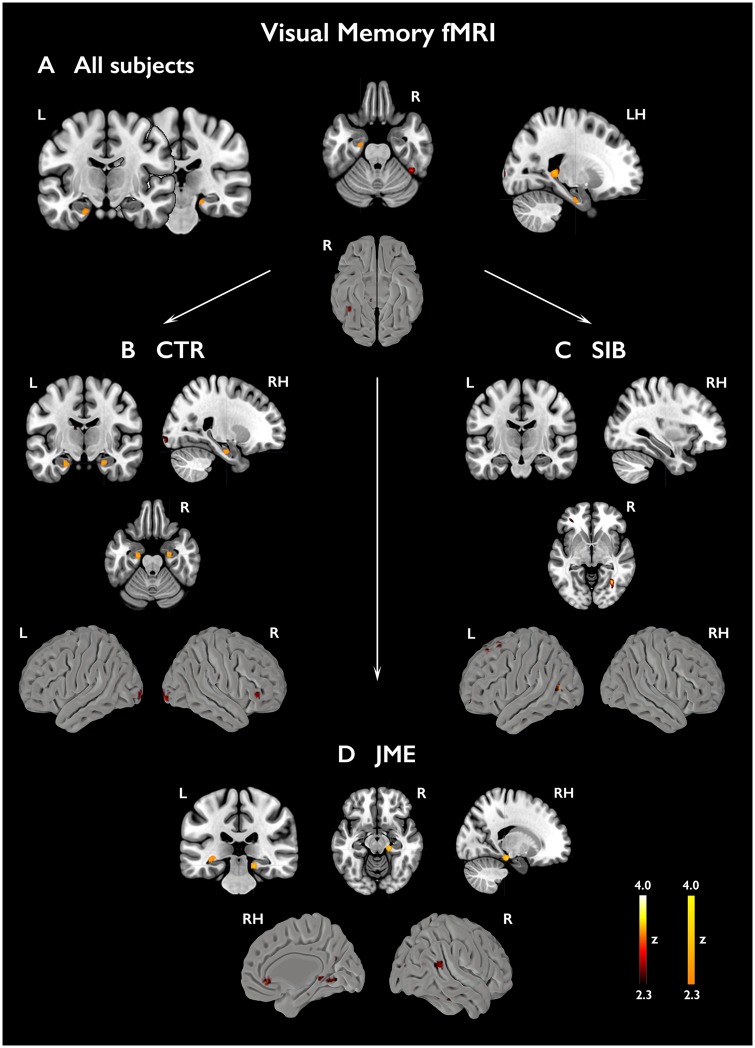

Activations related to subsequent visual memory. Mesiotemporal activations in relation to subsequently remembered visual items (FR – FF) are shown across all subjects (A) as well as separately for each group [B, controls; C, siblings (SIB); D, patients with JME]. Statistical maps for mesiotemporal activations (orange-yellow scale) show voxels included in the 12-mm diameter spherical regions of interest used for multiple comparison correction, where peak-level significance at P < 0.05-FWE corresponds to z-scores >2.3). Extra-mesiotemporal activations are displayed at an uncorrected threshold (P < 0.01, cluster extent threshold of 10 voxels; ‘hot’ colour scale). Colour bars reflect z-score scales for mesiotemporal (right) and extra-mesiotemporal (left) activations. ‘LH/RH’ refer to sagittal sections of the left/right hemisphere, respectively. MNI coordinates and parameter estimates are provided in Supplementary Table 4.